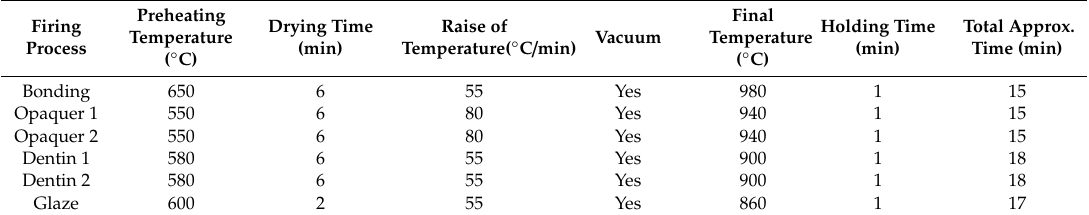
Table 2. Summary of the porcelain fused to metal (PFM) veneering procedure used in this